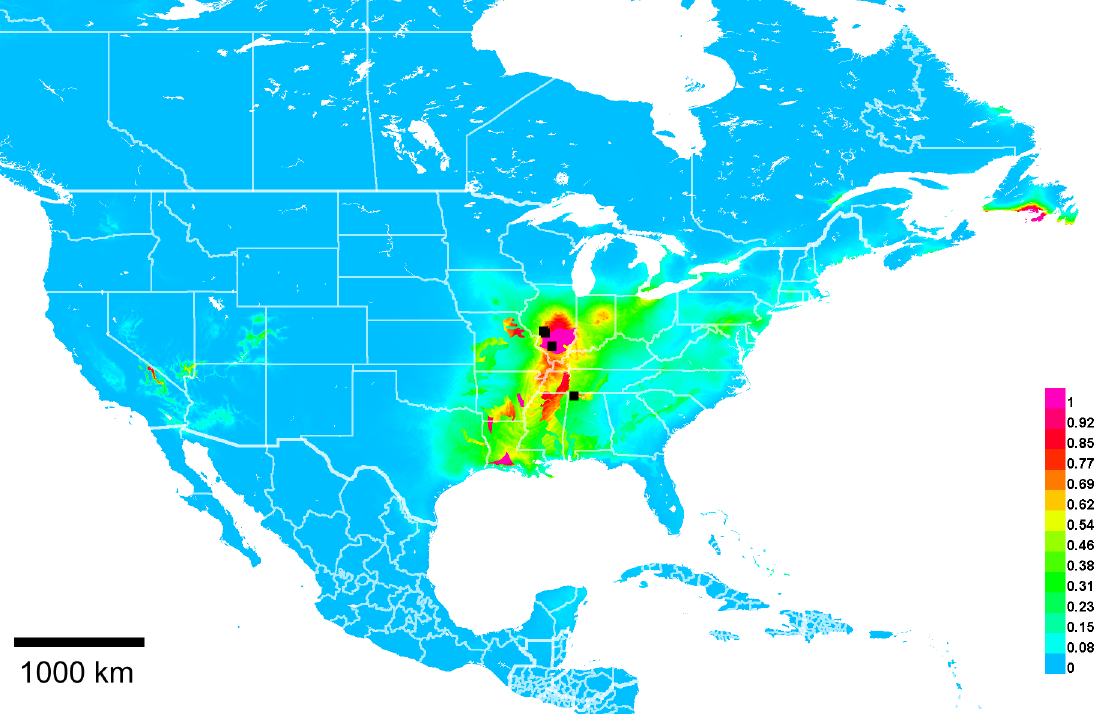
Fig. 8. Georeferenced collection records of Lasioglossum ( D .) carlinvillense (black squares) and predicted distribution by maximum entropy ecological niche modelling in Maxent (colour shading). Warmer colours indicate higher cloglog probability of